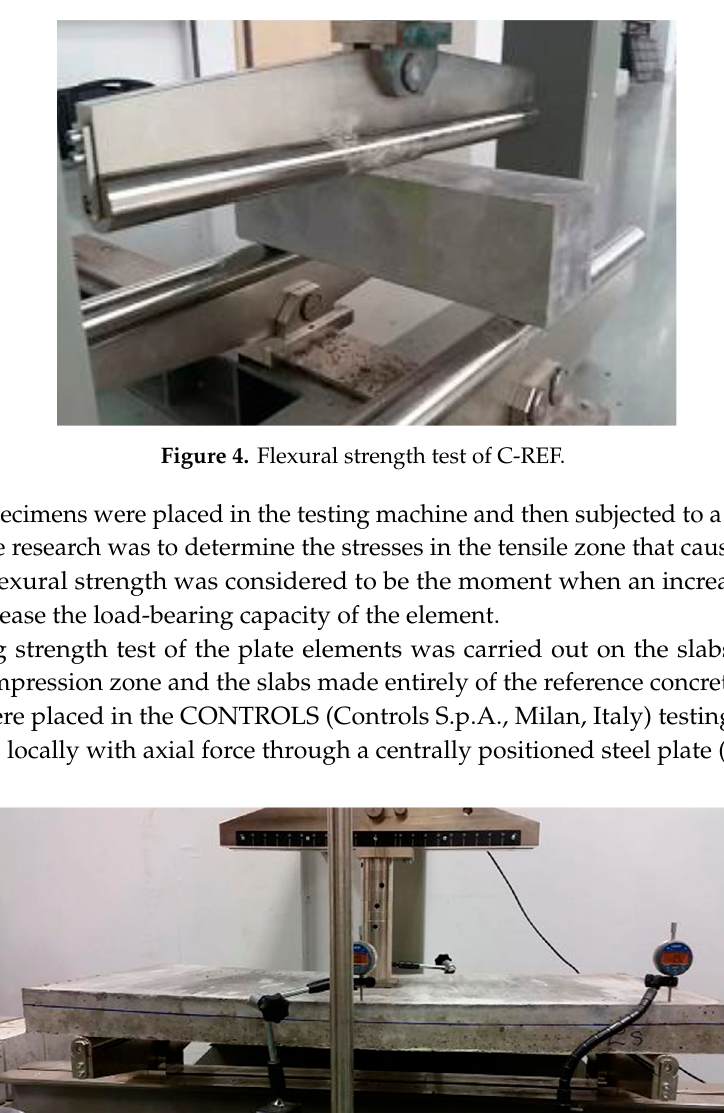
Figure 5. Bending resistance test of a concrete slab—specimen sample subjected to a local axial force.